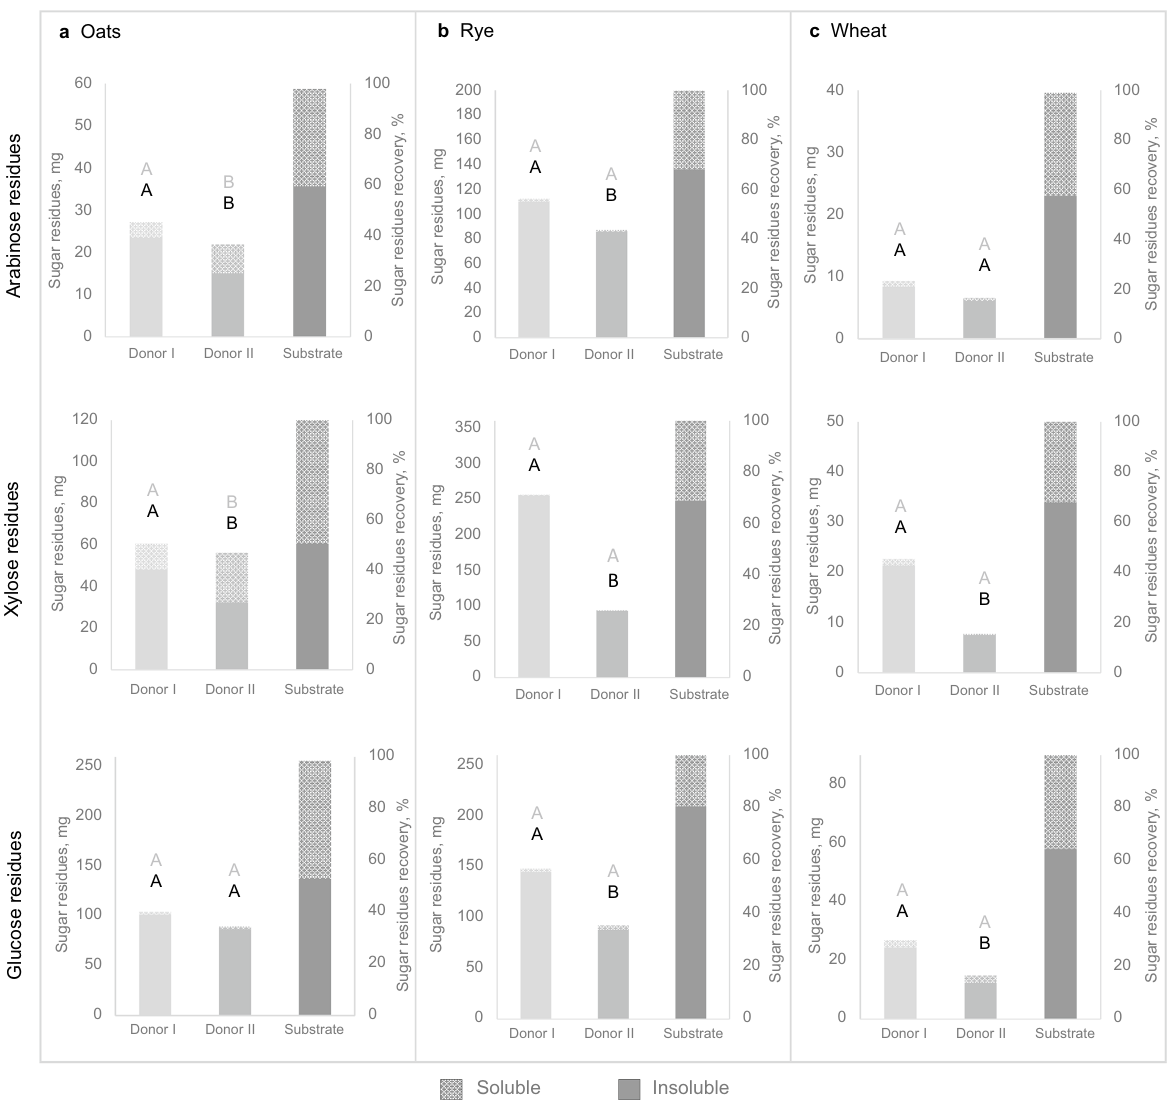
Figure 4. Amount and percentage recovery of arabinose, xylose, and glucose residues after 24 h of fermentation, and sugar residue composition in substrates in ( a ) oats, ( b ) rye and ( c ) wheat. Sugar residue amount varied between the substrates due to differences in fiber composition and substrate amount. Each bar includes soluble and insoluble sugar residues separately (mean of n = 4 replicates), and different letters (grey for soluble and black for insoluble sugar residues) above bars indicate statistically significant differences (p < 0.05) in pairwise comparisons between the two donor samples. Oats, rye and wheat indicate samples with fermentation